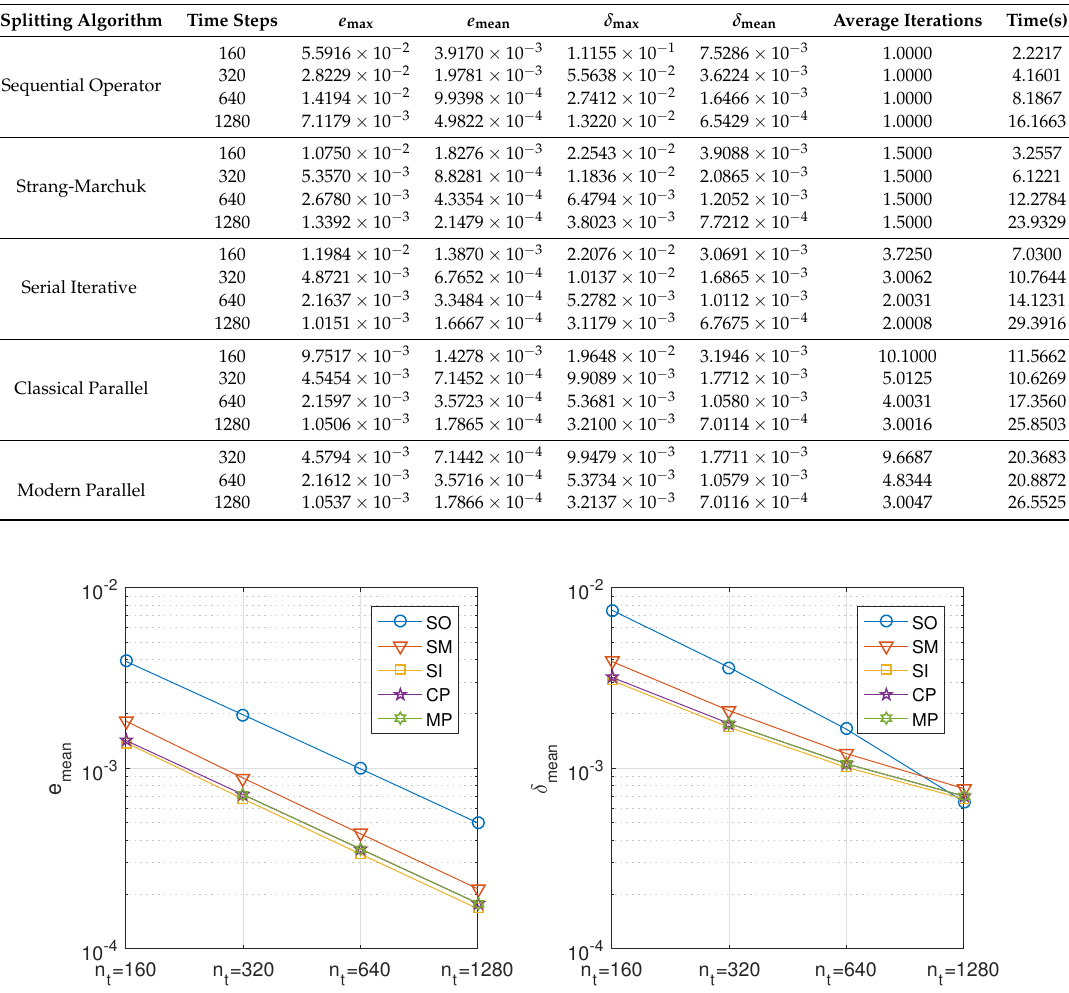
Table 13. Mixed convection-diffusion and Burgers’ equation. Results for the convection diffusion decomposition using the second order scheme for the spatial discretization with 10 spatial subintervals and different number of temporal steps.